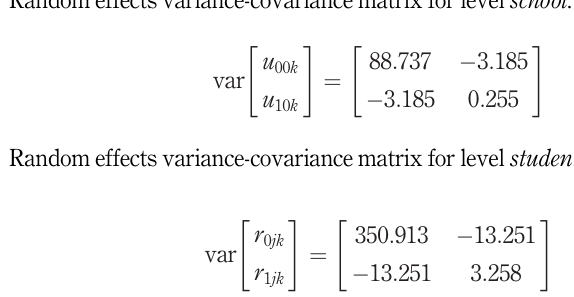
Figure 14. Variance-covariance matrices with correlated random effects ( u 00 k , u 10 k ) and ( r 0 jk , r 1 jk )